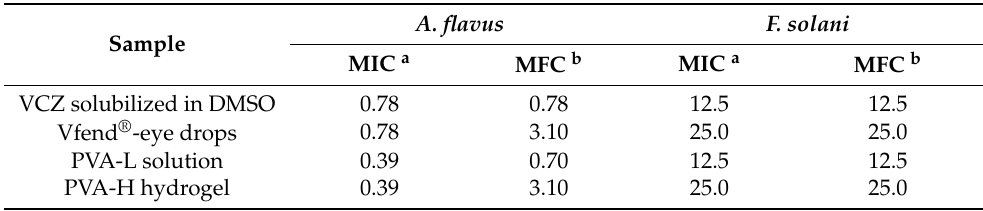
Table 7. In vitro antifungal activities of VCZ in DMSO, Vfend ® eye drops and VCZ/SBE β CD-loaded PVA-L solution and PVA-H hydrogel against fungal species (mean, n = 3).